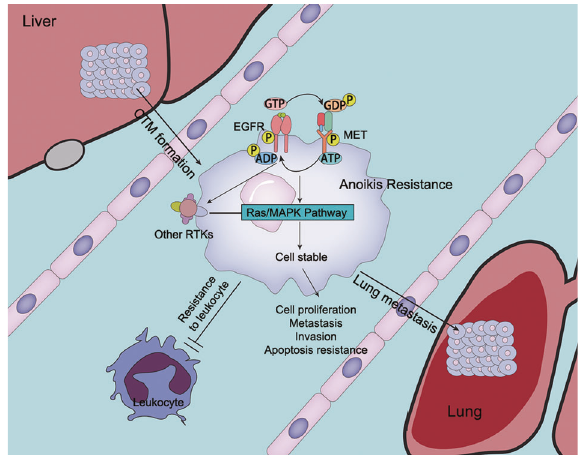
Fig. 8 A proposed model of EGFR/MET-mediated in HCC and metastasis. After metastasis to blood, both expression and phosphorylation of EGFR/MET was up-regulated in CTM. Based on high expression, EGFR/MET could induce phosphorylation of other RTKs via ATP production, and over-phosphorylation of RTKs were independent to RTKs ligand and resistant to RTKs inhibitors. Compared to other RTKs, EGFR/MET could more effectively activate Ras/MAPK pathway. Activation of Ras/MAPK pathway participate in cell proliferation, resistance to apoptosis and stabilization of suspended HCC cells. Also, EGFR/MET mediated in helping CTM to avoid killing effect of leukocytes.